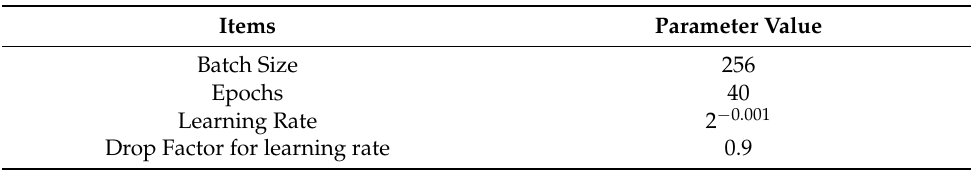
Table 1. The pa rameter configuration for DNN training. Table 1. The parameter configuration for DNN